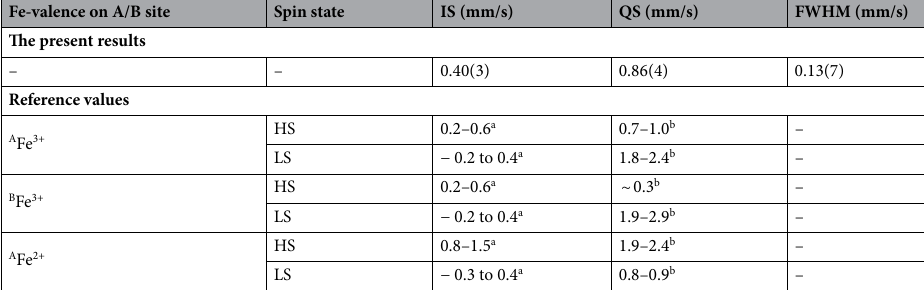
Table 2. Comparison of hyperfine parameters from synchrotron Mössbauer spectroscopy with their reference values. IS isomer shift, QS quadrupole splitting, FWHM full width at half maximum, HS high spin, LS low spin; superscripts A and B represents A and B sites, respectively. a Ranges of IS for Fe reported in a variety of compounds 41 . b Ranges of QS for Fe in bridgmanite calculated theoretically 42